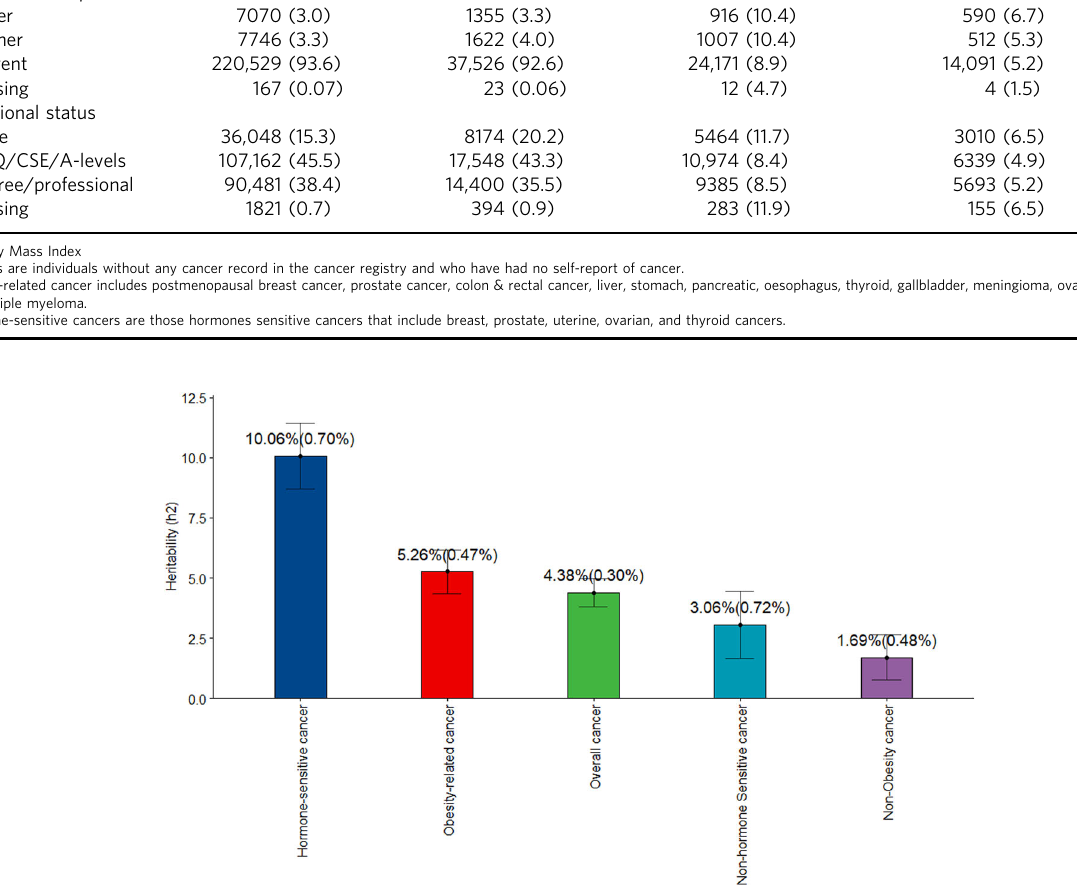
Fig. 1 Estimated SNP-based heritability of grouped cancers using greml approach in the UKB. It is shown that the h 2 for hormone-sensitive cancers is the highest among the other groups of cancers. The error bars are the 95% con fi dence interval of the estimates. The y axis shows the heritability estimates for each grouped cancer in